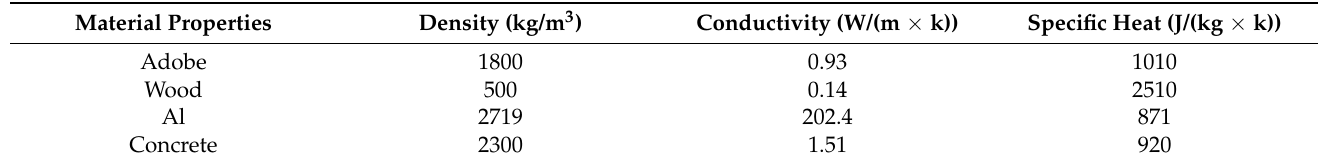
Table 2. Material properties of the venturi cap.